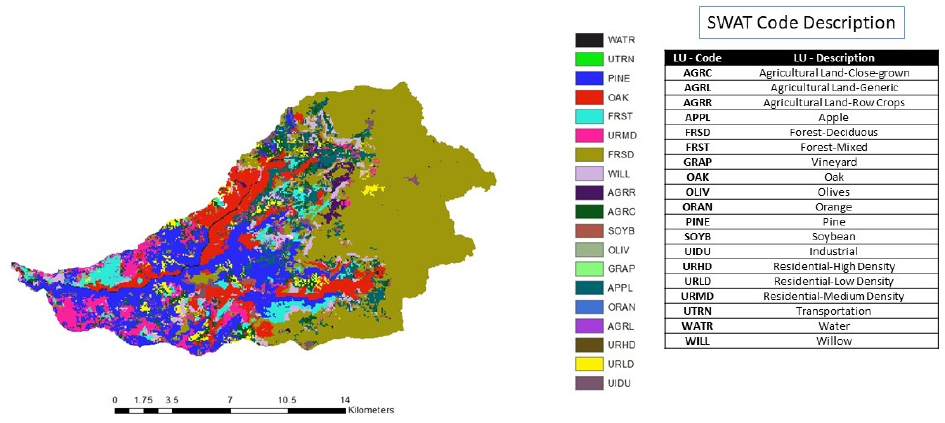
Figure 5. SWAT land use distribution in El Kalb watershed.